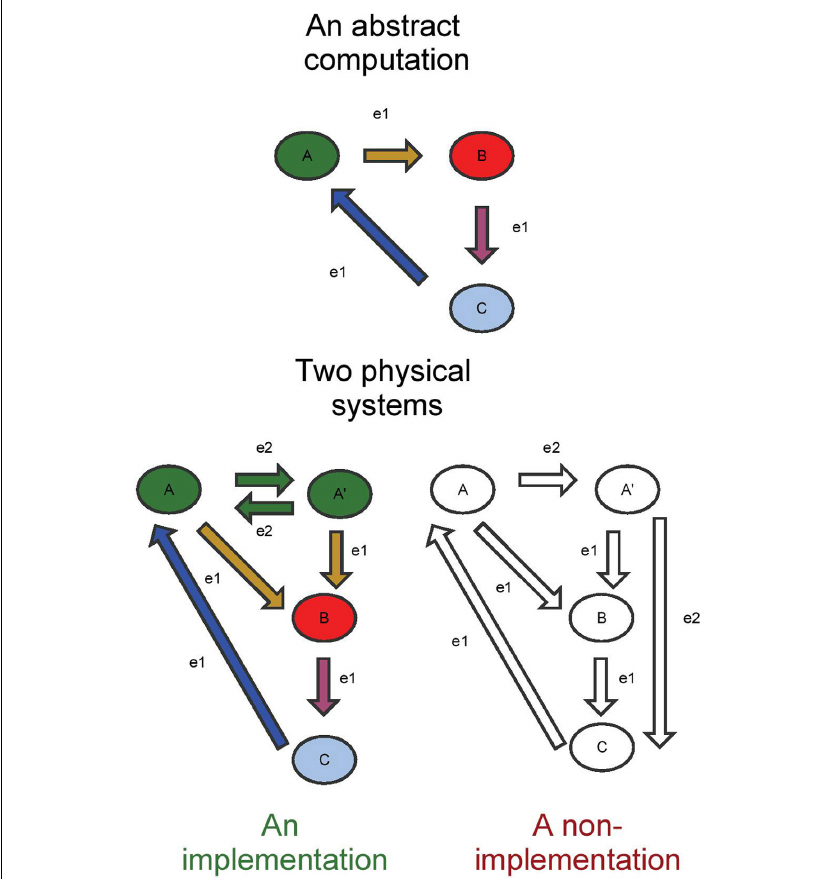
FIGURE 1 | A simple implementation and a non-implementation. The correspondence between states/transitions is color coded for the implementation. The transitions in green in the physical system can be seen as transitions leading from the green state in the abstract system to itself. e1 and e2 indicate possible events marking the transitions between states. In the non-implementation, the fact that e2 leads away from state A’ (instead of back to A) prevents the existence of a consistent mapping to states/transitions in the abstract